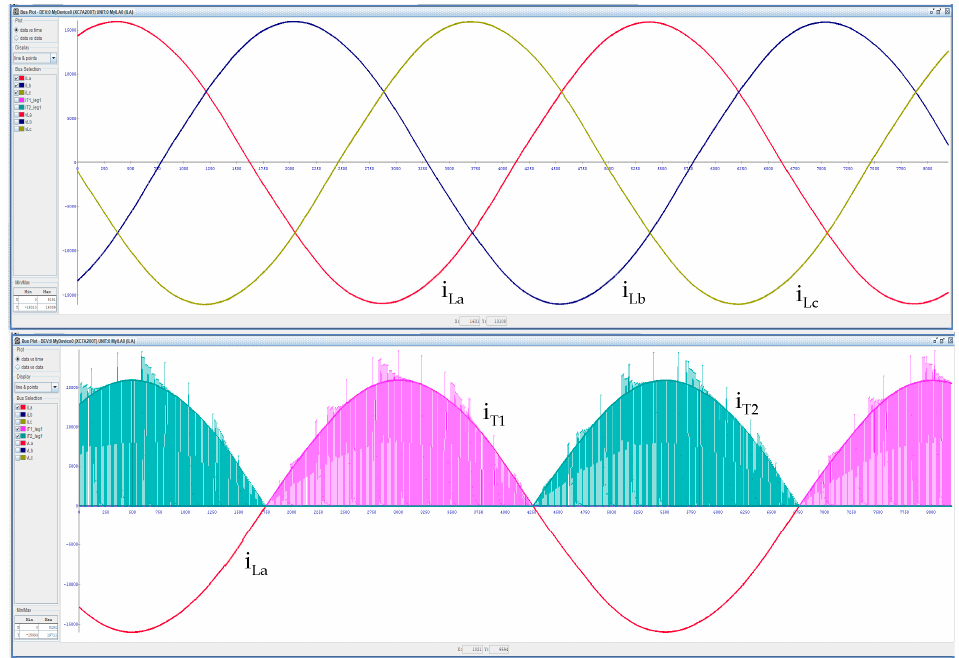
Figure 7. RT results for the three-phase VSI–waveforms of the currents.